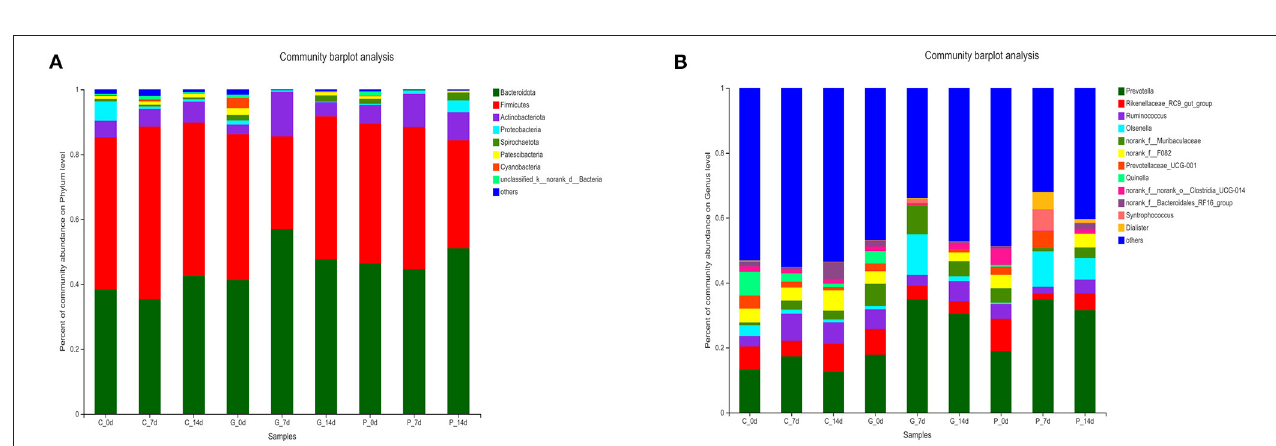
FIGURE 3 | Composition of rumen bacterial community at the phylum level. (A) Bar chart of phylum level in each treatment group; (B) The proportion of each common bacterium at the phylum level.